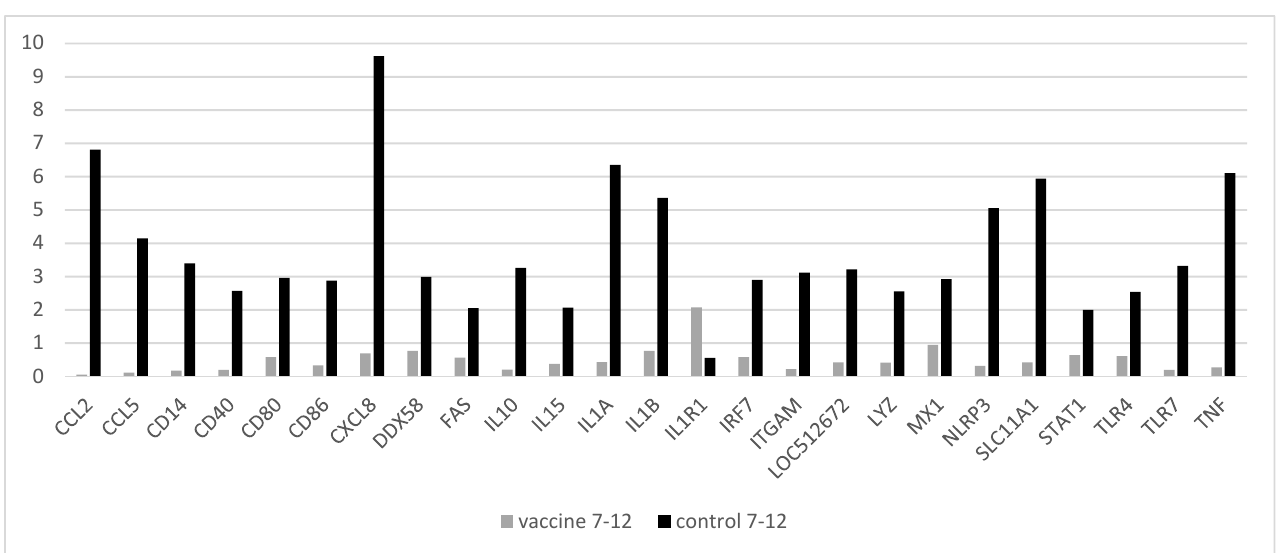
Figure 4. Comparison of gene expression (fold-change on Y -axis) of non-vaccinated control animals versus vaccinated animals after challenge with BPIV3 from day 7 to 12. All genes are shown which had significant changes to Ct values five days after challenge in both groups (see materials and methods). Only IL1R1 was significantly increased in the vaccinated group.